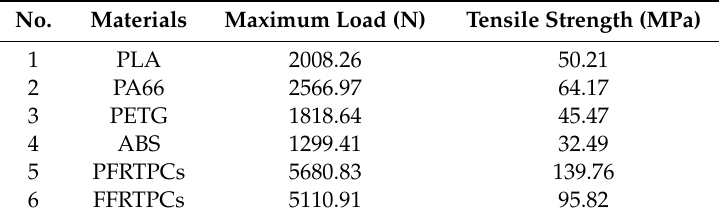
Table 3. Maximum load and tensile strength.